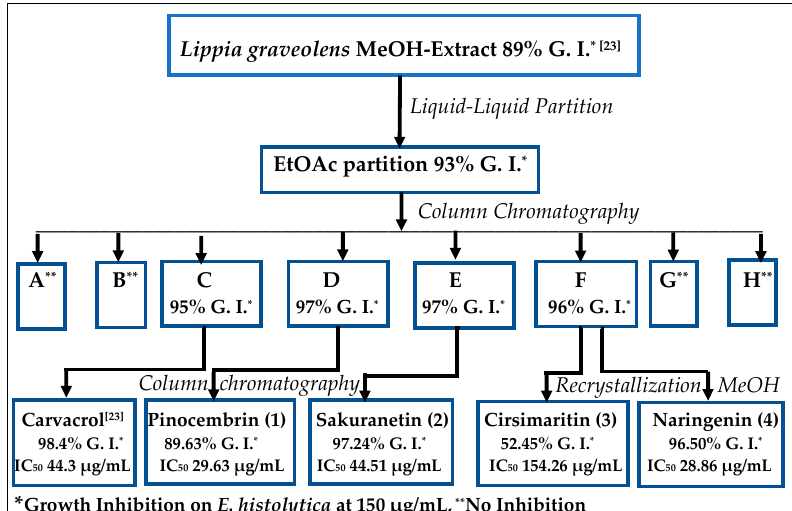
Figure 1. General scheme for the bioguided isolation of compounds with antiamoebic activity from Lippia graveolens Kunth (Mexican oregano). reported in the literature.